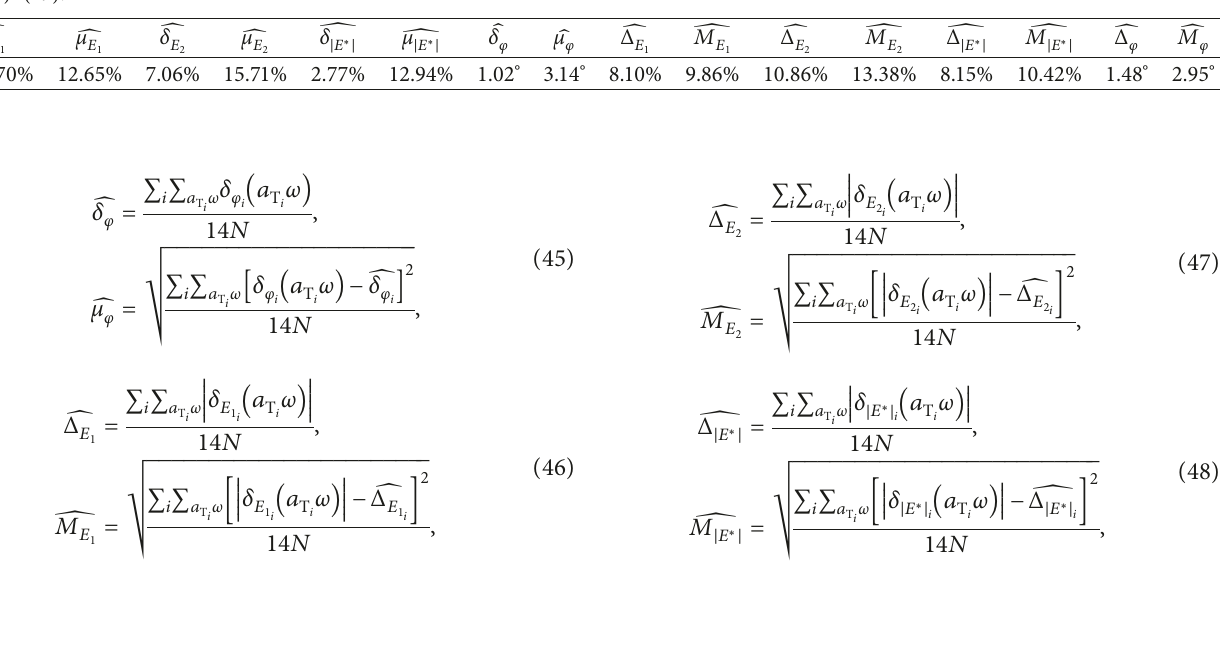
Table 4: Global errors of 2S2P1D model fitting for a bituminous mixture, calculated for the whole calibration panel according to equations